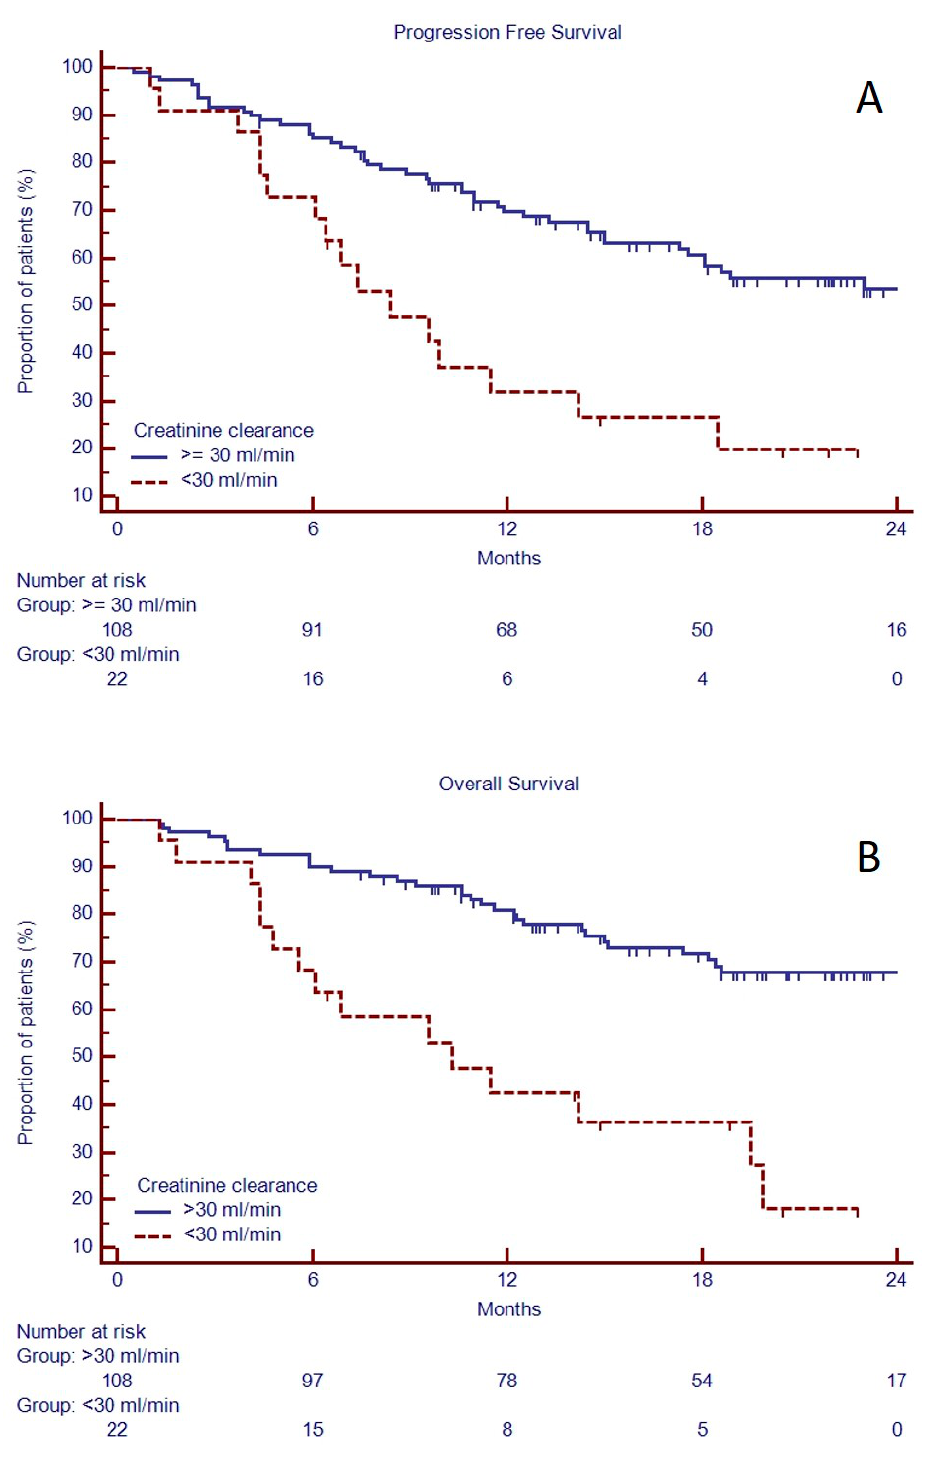
Figure 3. Progression free survival ( A ) and overall survival ( B ) based on previous exposure to lenalidomide in 130 RRMM candidates to KRd as salvage regimen in a real-life approach. Both PFS and OS were affected by kidney function, as shown in univariate and multivariate analysis (Table 5, Figure 4). Indeed, median PFS and OS were longer in patients with clearance creatinine >30 mL/min (respectively, 27.0 vs. 8.4 months, p = 0.0003, HR 2.72, 95% C.I. 1.24–5.98 and unreached median vs. 10.3 months, p < 0.0001, HR 3.59, 95% C.I. 1.47–8.78).